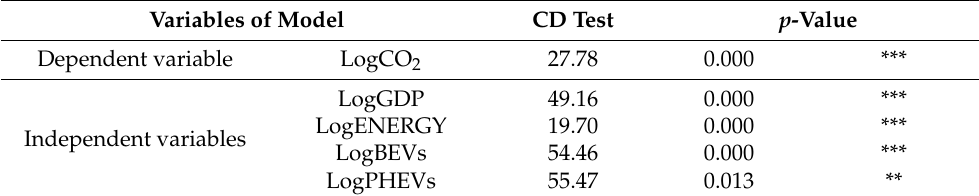
Table 5. Pesaran CD test.